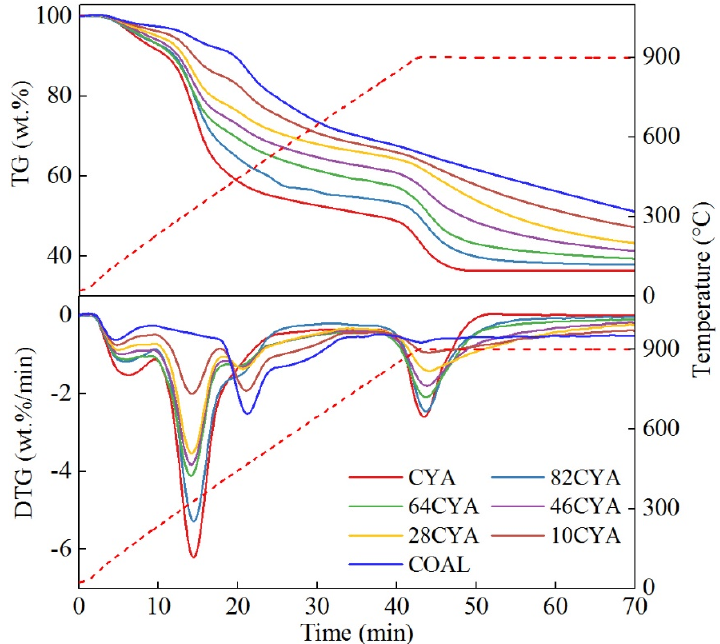
Figure 2. The TG and DTG curves of the co-gasification and single fuel gasification with a 2:1 fuel / OC mass ratio under argon / steam atmosphere. CYA, cyanobacteria.